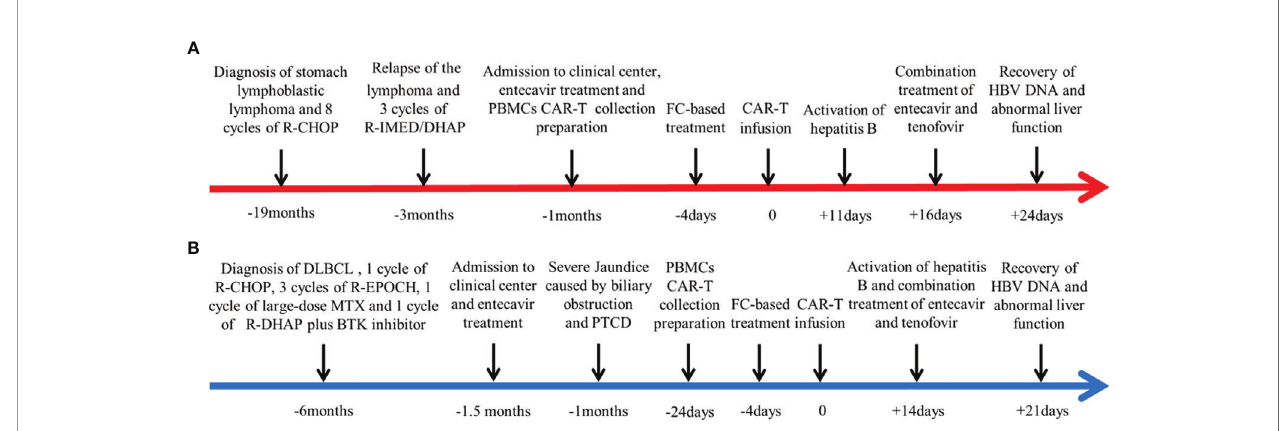
FIGURE 1 | Summaries of the two cases. The fi rst day of chimeric antigen receptor (CAR) T-cell infusion is established as day 0. (A) Key clinical course of case 1. (B) Key clinical course of case